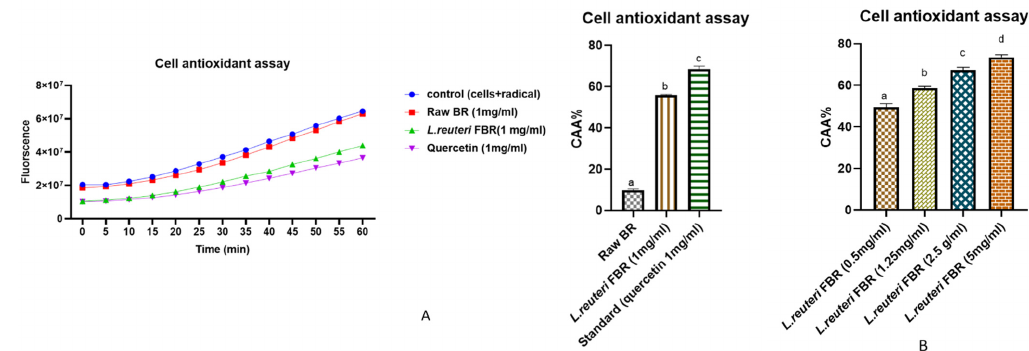
Figure 5. In Caco-2 cells, peroxyl radical-induced oxidation of DCFH to DCF and ROS inhibition by raw BR and L. reuteri FBR extract ( A , B ) showing the effect of dose-dependent inhibition of L. reuteri FBR extracts (0.5–5 mg/mL). Data were represented as means ± standard deviations ( n = 3) with one way ANOVA. The columns with different letters (a–d) show significant differences using Tukey’s test at p < 0.05.